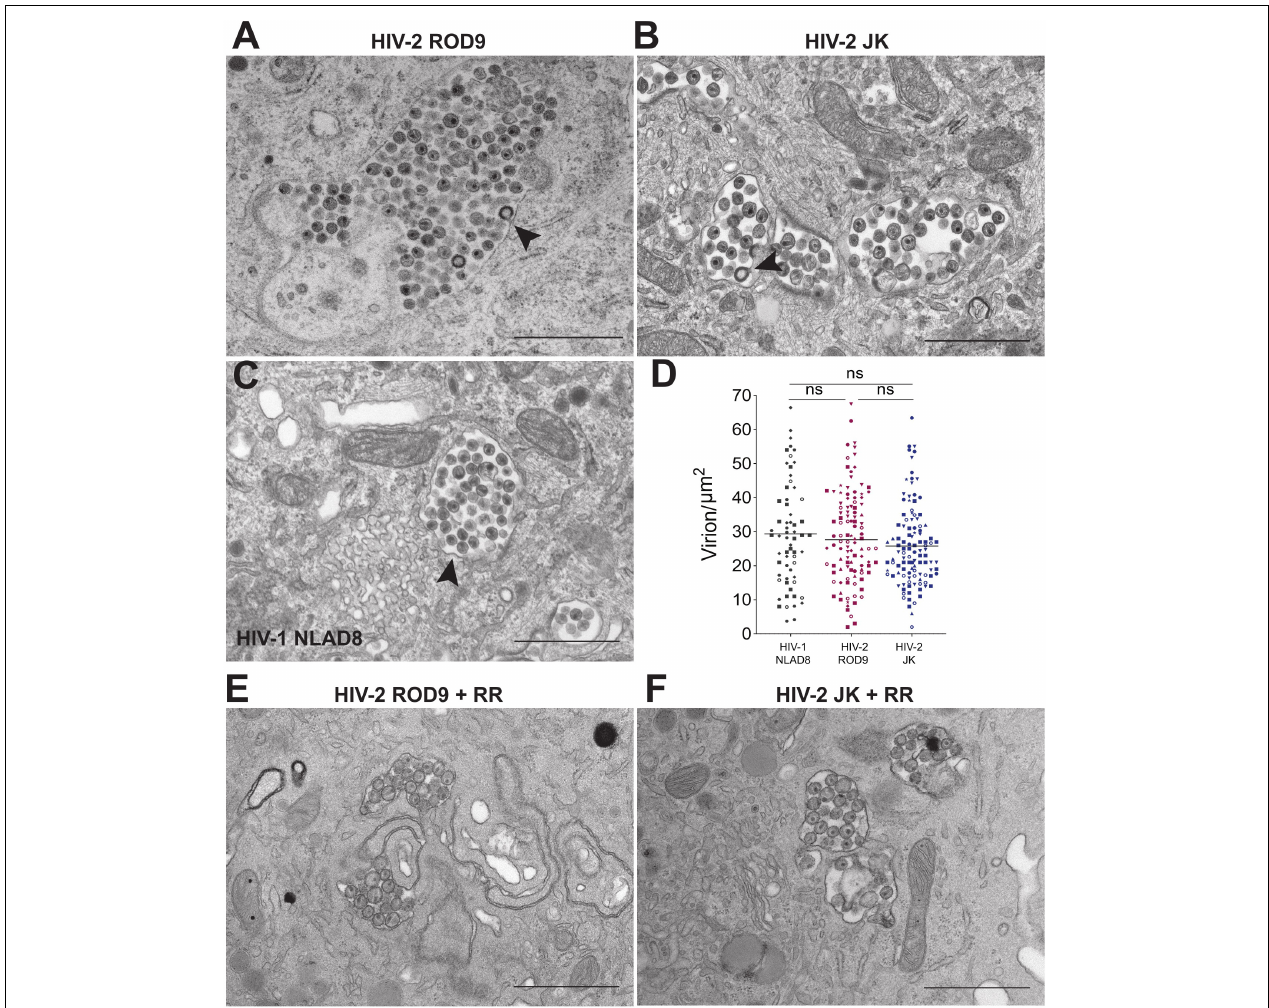
FIGURE 4 | HIV-2 assembles and buds in bona fide VCC of MDMs. (A–C) MDMs infected with the indicated pseudotyped viruses for 3 days were fixed and processed to perform electron microscopy (see section “Materials and Methods”). A representative epon section of infected MDM from 5 donors is presented. Arrowheads point to nascent viral buds. (D) Quantification of the density of viral particles present within the VCCs calculated for each epon sections of infected MDMs. Each dot represents a VCC. Bars represent Grand means. Donors: NLAD8 n = 4, ROD9 n = 7, and JK n = 5. (E,F) MDMs infected with the indicated pseudotyped viruses for 3 days were fixed in the presence of Ruthenium Red and processed to perform electron microscopy. P -values were calculated using Kruskal–Wallis non-parametric test with Dunn’s correction for multiple comparison. P -values lower than 0.05 were considered as significant (* p < 0.05, ** p < 0.01, *** p < 0.001, **** p <